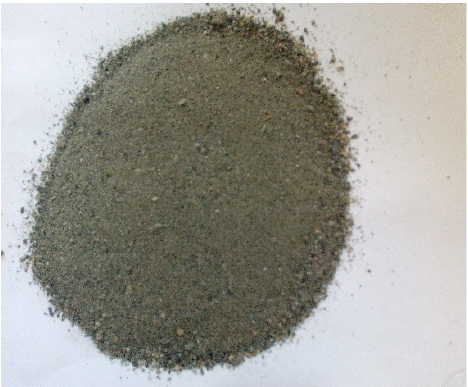
Figure 2 . Sirjan Gol Gohar iron mine waste